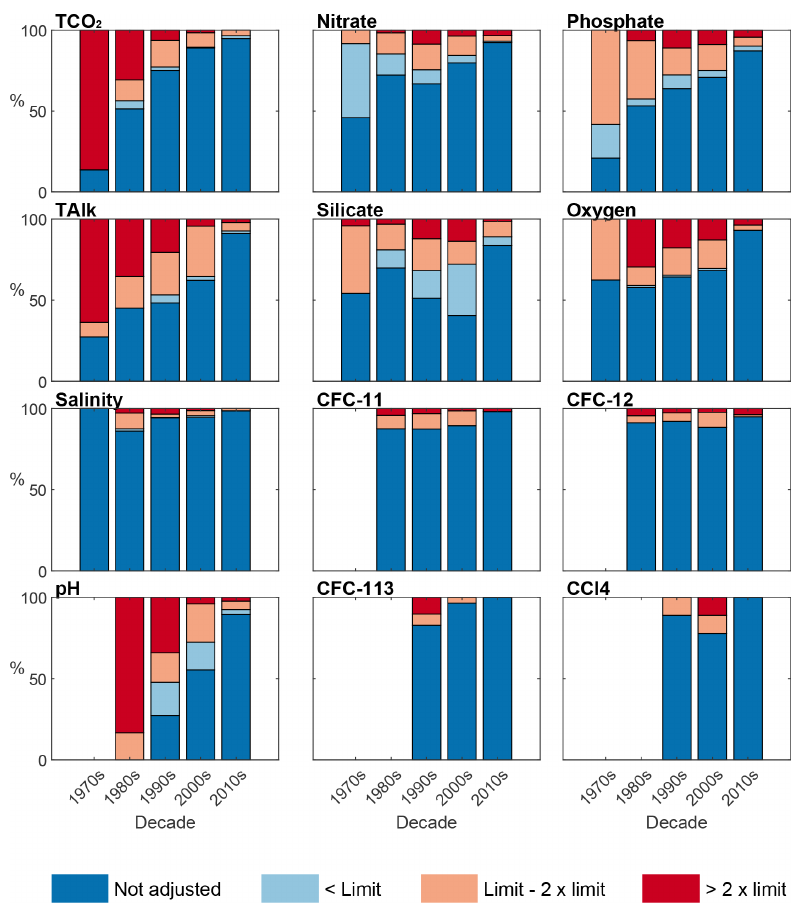
Figure 7. Magnitude of applied adjustments relative to minimum adjustment limits (Table 3) per decade for the 989 cruises included in